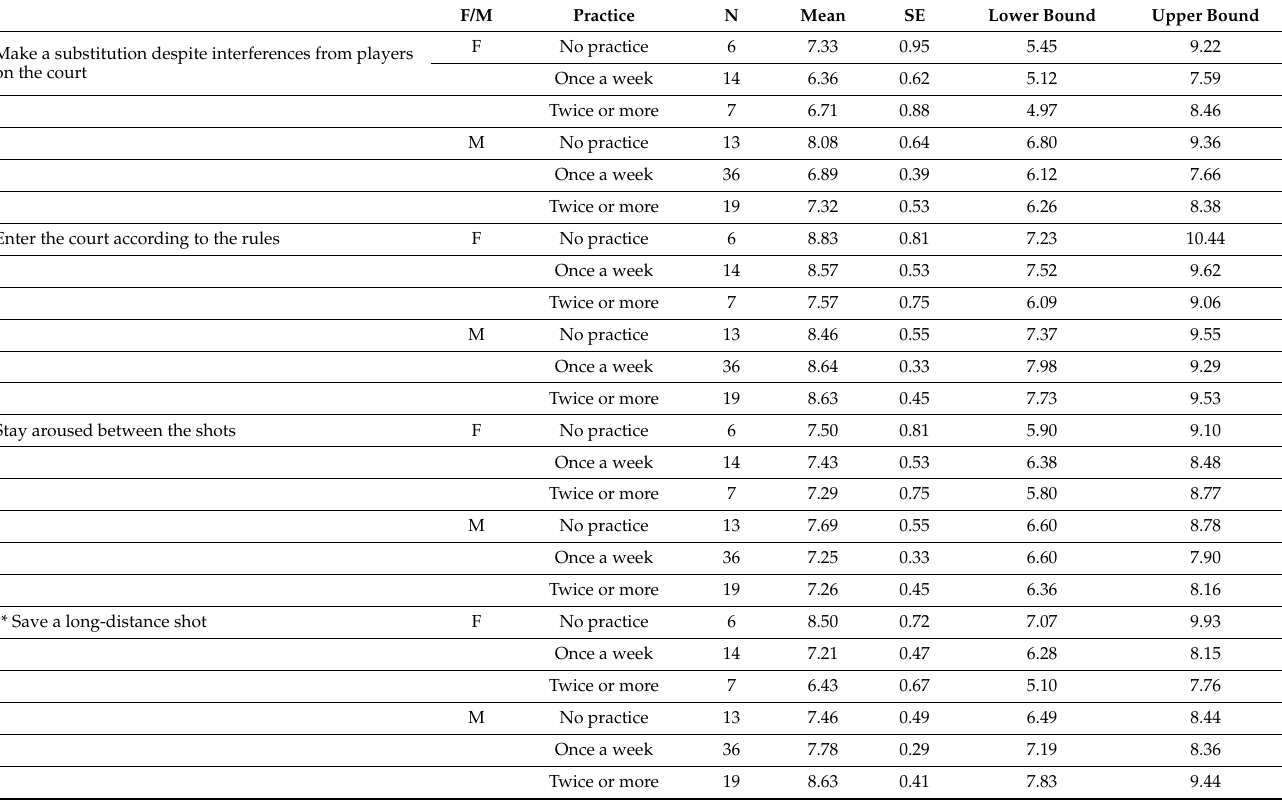
Table A1. Responses to 10 confidence items by gender and amount of